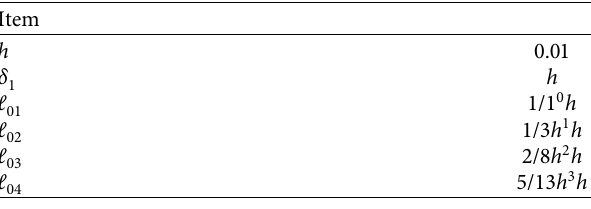
Table 2: TD parameter table.